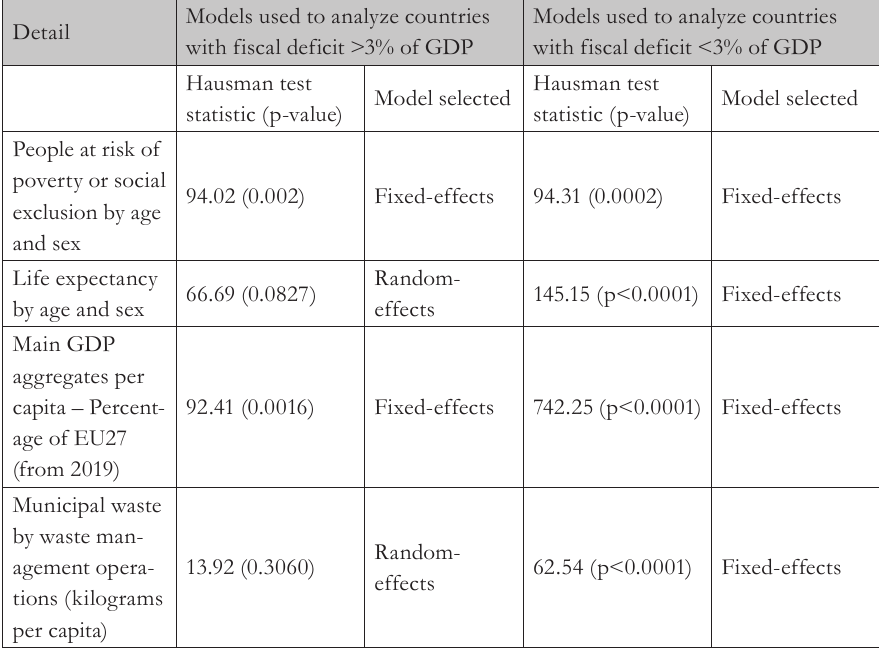
Tab. 3 – Hausman tests for the models analyzed. Source: own